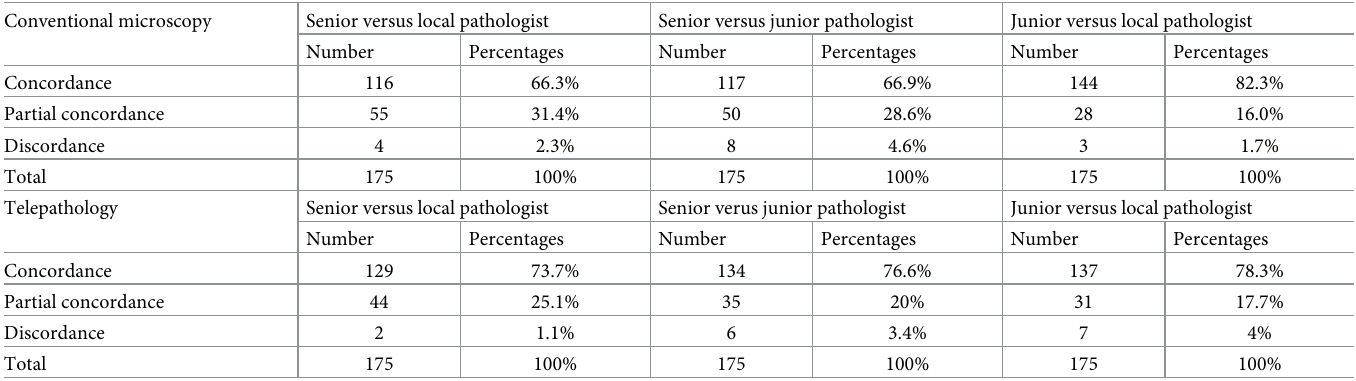
Table 4. Three-point scale agreement of diagnoses established by senior pathologist compared to local and junior pathologists on conventional and scanned images. Conventional